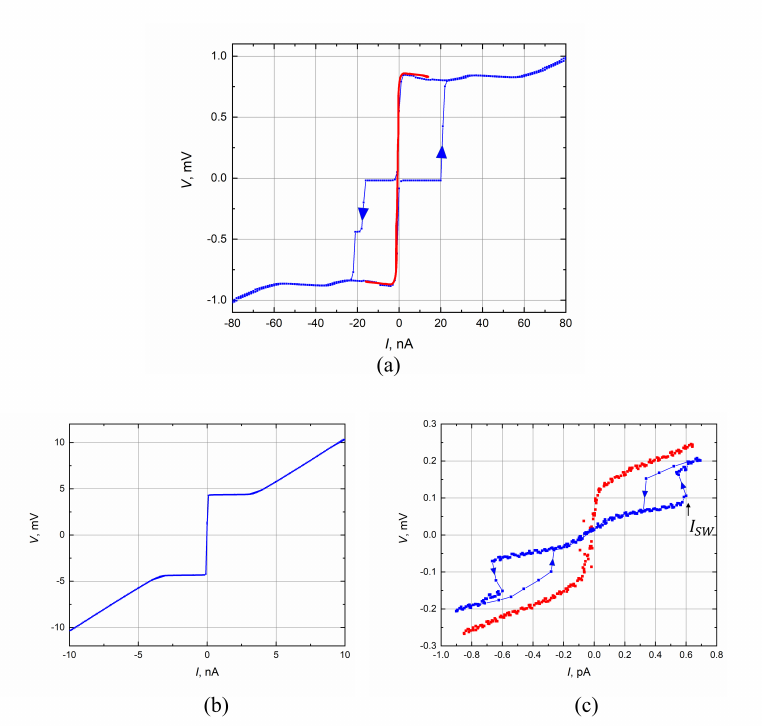
Figure 2. ( a ) Current-voltage characteristics of two connected-in-series SQUIDs at Φ = 0 (blue curve) and Φ = 0.5 Φ 0 (red curve) at T ≈ 30 mK. Each SQUID is formed by two nominally identical JJs with E J = 0.76 K (sample 3 in Table 1), thus the SQUID Josephson energy is 1.52 K . Even for this circuit with relatively high E J , the measured switching current per junction, I SW = 9 nA, is significantly lower = 33 nA. ( b ) The IVC of a chain of 20 SQUIDs with E = 80 mK (for single-JJ parameters, than I AB J C see sample 6 in Table 1). ( c ) The enlargement of the region of small currents/voltages in panel ( b ). Note that the resistance is non-zero for all biasing currents. The switching current (its value for a given sample, 0.6 pA, is indicated by an arrow) corresponds to a rapid increase of the voltage across the chain. This switching current is almost four orders of magnitude smaller than the I AB value for C this sample (see Table 1). The zero-bias resistance ( R 0 ≈ 500 M Ω per junction) was determined as the slope of the IVC at I (cid:28) I SW